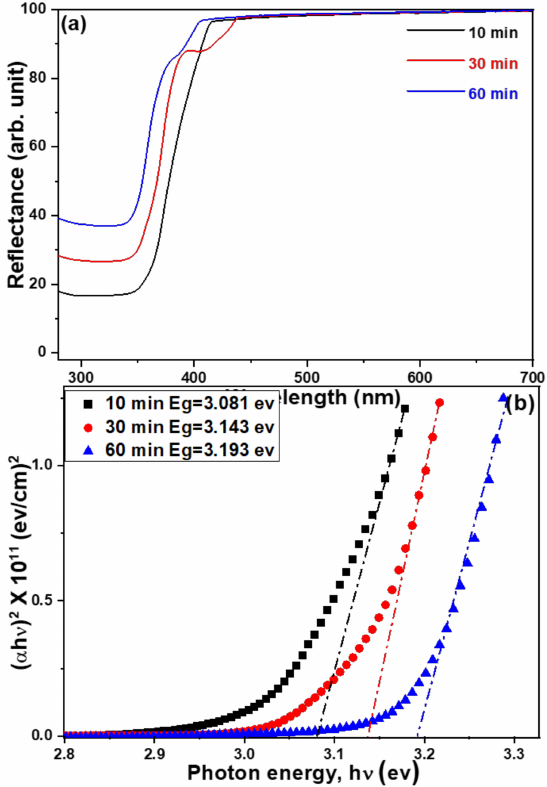
Figure 8. ( a ) UV–visible diffusion reflectance spectra and ( b ) Tauc plots for UV–visible reflectance spectra of ZnO NFAs using different synthesis